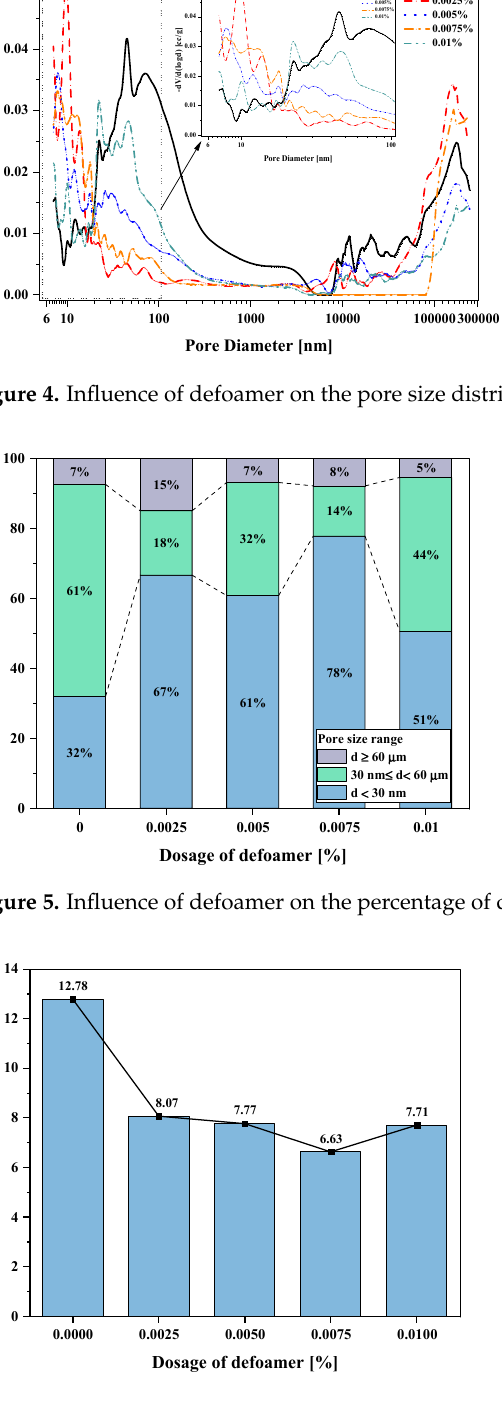
Figure 6. Influence of defoamer on the porosity of grouts.